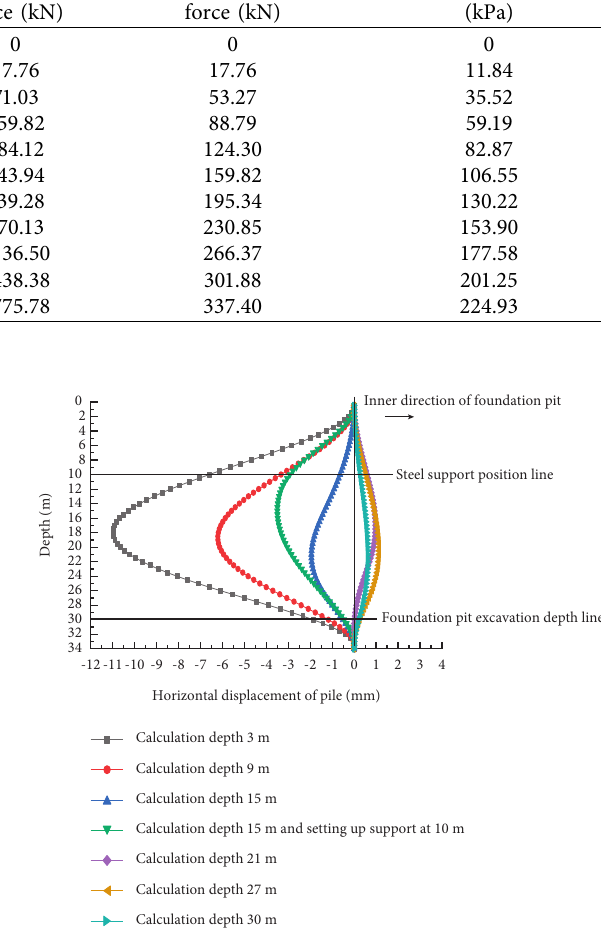
Figure 10: Displacement curves of a pile obtained via finite ele- ment calculations for a pole system (incremental